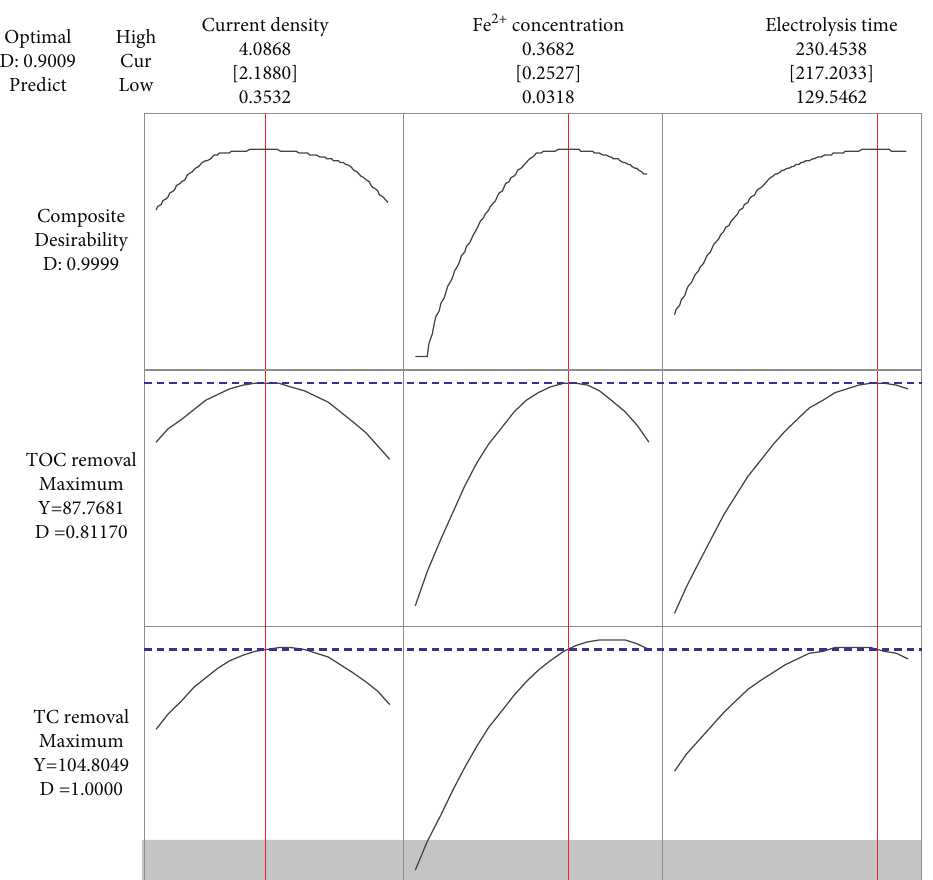
Figure 5: Response optimization plot of maximum both TOC and TC removal